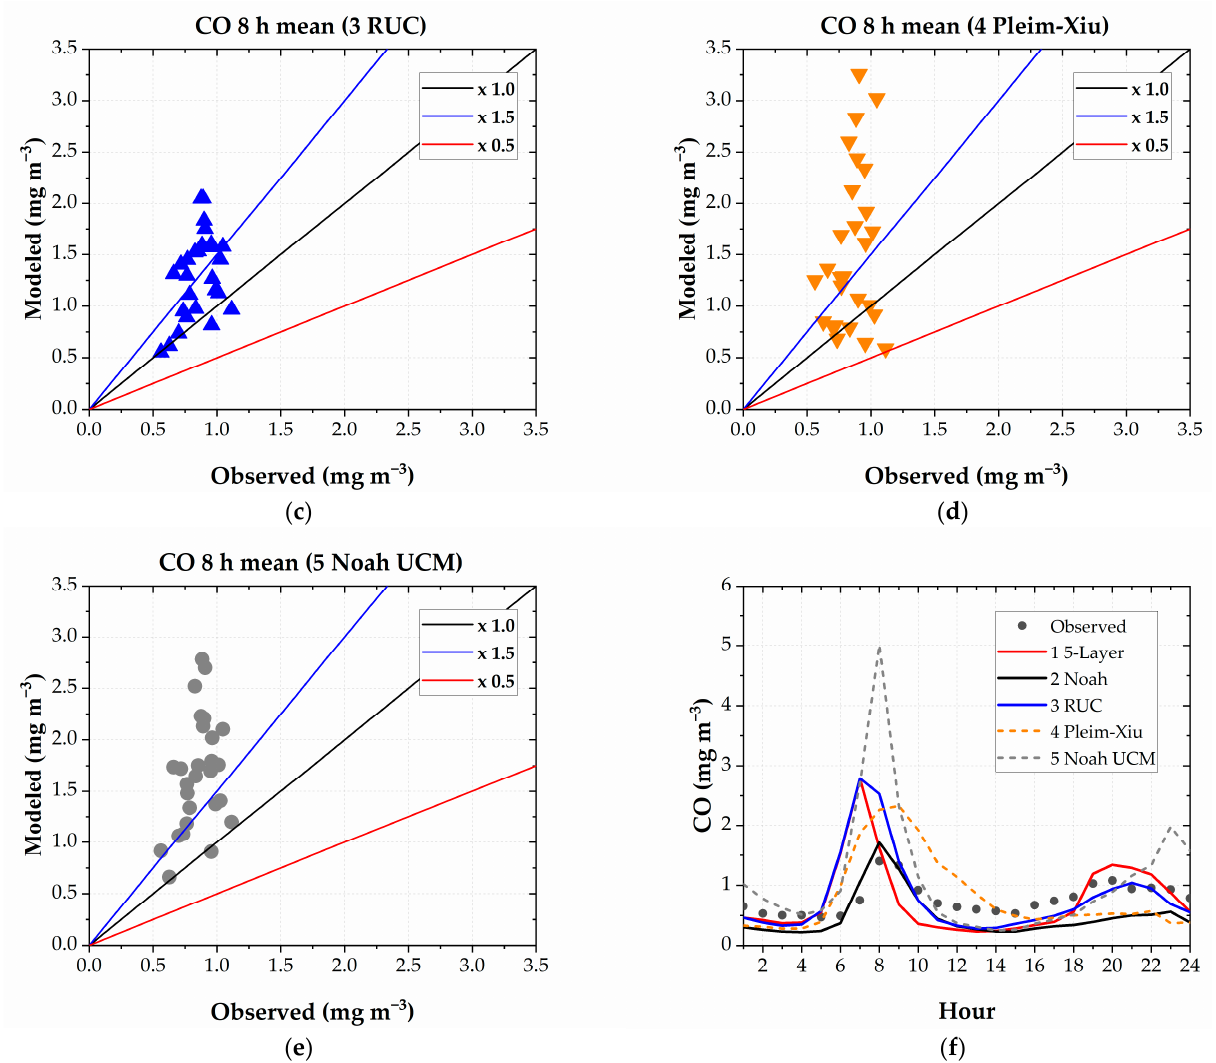
Figure 6. Observed versus modeled daily CO 8 h maximum mean at the MUN station: ( a ) 1 5-Layer; ( b ) 2 Noah; ( c ) 3 RUC; ( d ) Pleim–Xiu; ( e ) 5 Noah UCM. ( f ) The mean daily profile of hourly CO concentrations. Table 7. Metrics for short-term air quality modeling. Bold numbers highlight the schemes with the best performances.